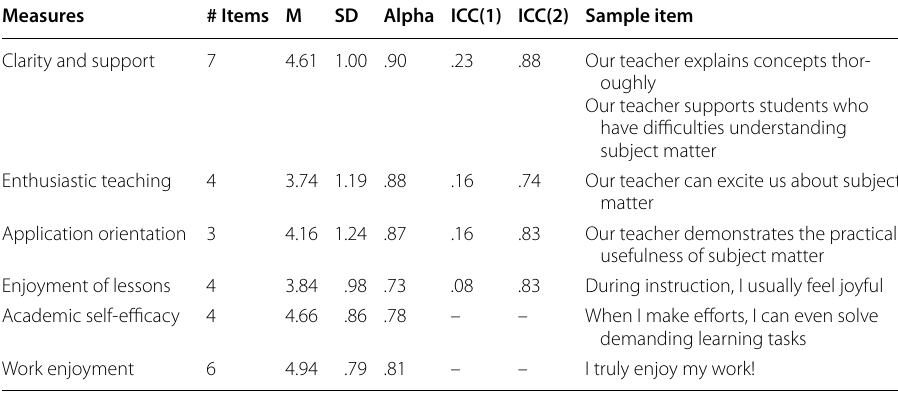
Table 1 Descriptive statistics and reliability measures for all